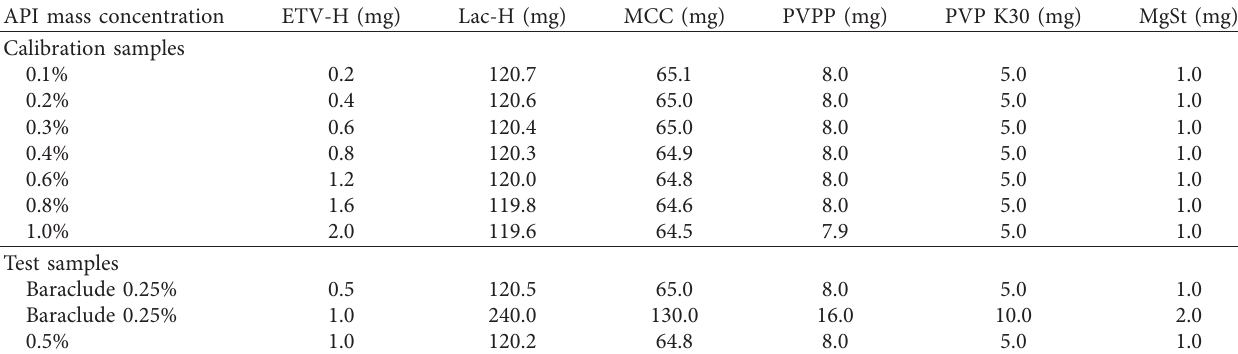
Table 1: Contents of each tablet with different API concentrations in calibration samples and test samples. API mass